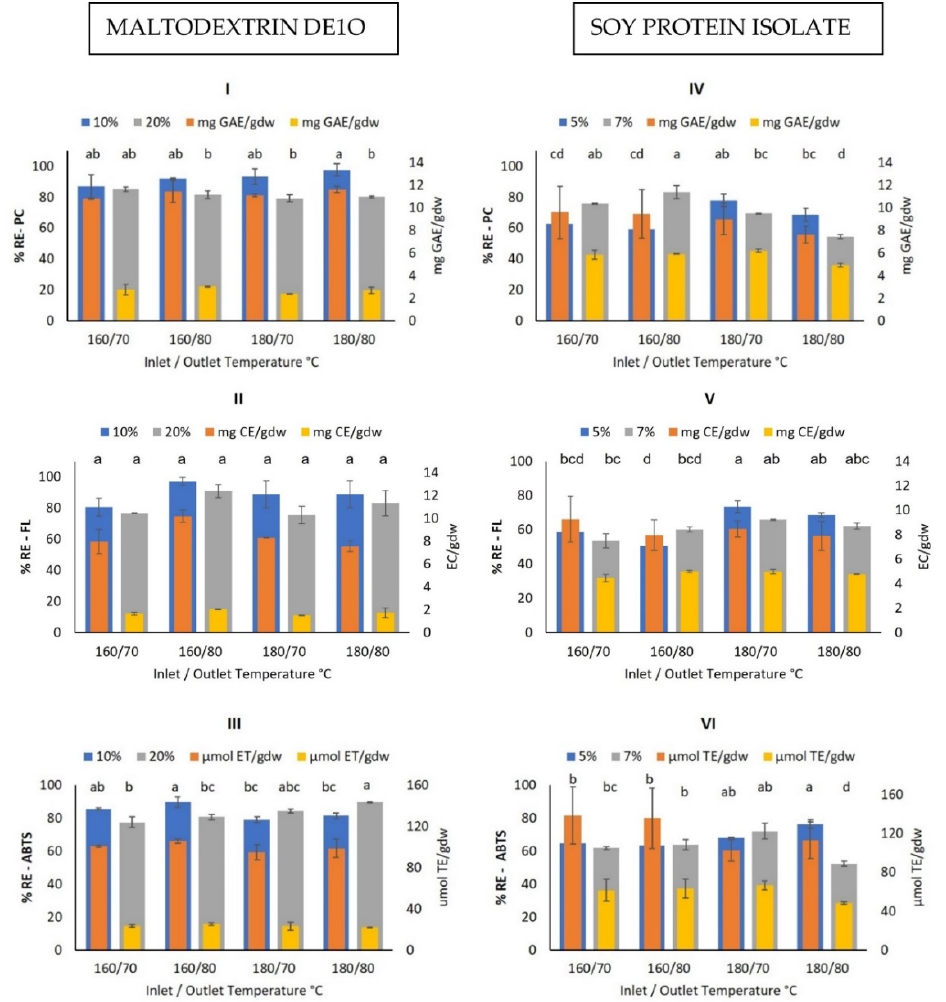
Figure 1. Retention efficiency (%RE) and content of bioactive compounds: PC, FL, and AC (ABTS) in microcapsules with MD DE10 (10 and 20% in drying solution), I, II and III respectively; and with SPI as encapsulating agent (5 and 7% in drying solution) IV, V and VI, respectively. Different letters indicate a significant difference at p < 0.05 for retention effi- ciency.